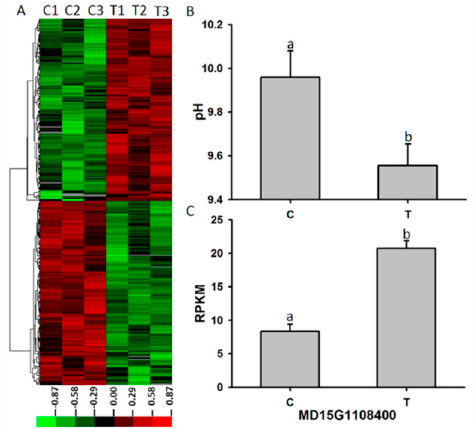
Figure 5. Transcriptome analysis of roots of Malus prunifolia (Willd.) Borkh. under alkaline treatment at 0 h (C) and 24 h (T). ( A ): Hierarchical clustering which represents the differential expression pattern indicated up- and downregulated genes. The numbers 1, 2, and 3 represent three biological replicates. ( B ): The change of hydroponics solution pH under alkaline stress. C and T represent the treat time 0 h and 24 h. ( C ): Digital expression of candidate gene MD15G1108400 based on transcriptome data under alkaline treatment at 0 h (C) and 24 h (T). The signification differences ( t- test, LSD test at p < 0.01) among C and T were indicated by different lowercase letters.